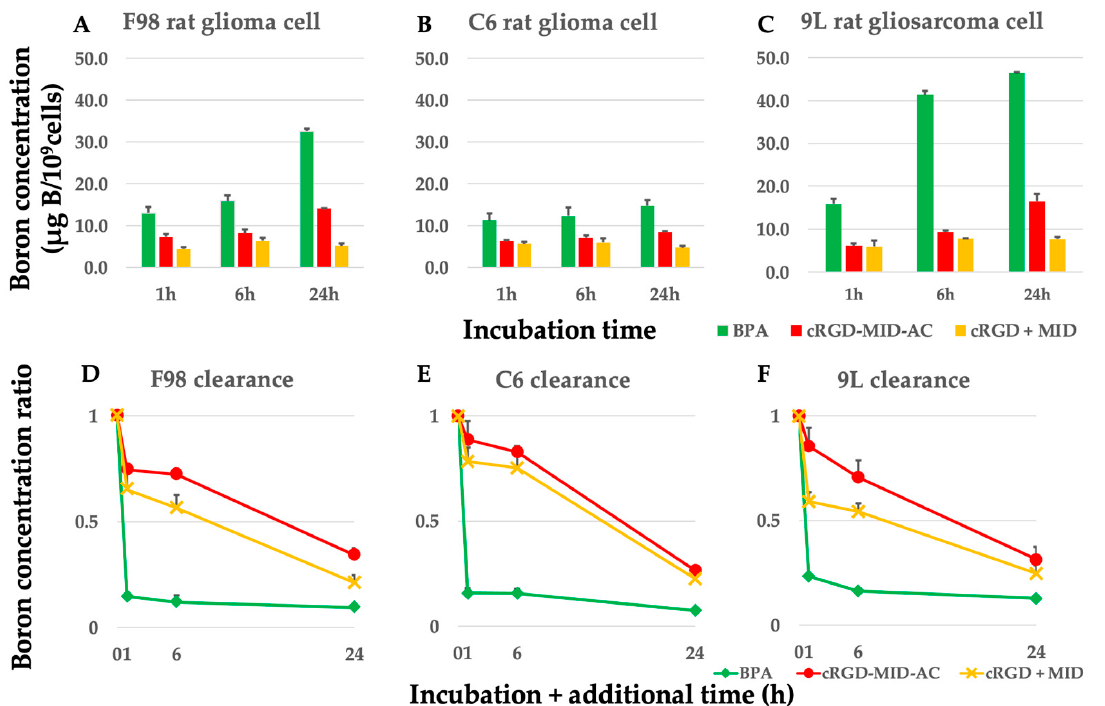
Figure 1. ( A – C ) Boron concentrations in all cell lines. All cell lines were incubated with 10 µg B/mL of BPA, cRGD-MID-AC, and cRGD + MID for 1, 6, and 24 h. The bar in each result indicates the standard deviation. ( D – F ) To show the retention ratio of boron of BPA, cRGD-MID-AC, and cRGD + MID, each cell line was incubated with 10 µg B/mL of BPA, cRGD-MID-AC, and cRGD + MID for 24 h with additional incubation with a boron-free medium for 0, 1, 6, and 24 h. The bar in each result indicates the standard deviation. The boron concentration of BPA from 1 h to 24 h in all cell lines was significantly higher than that of cRGD-MID-AC and cRGD + MID ( p < 0.05).